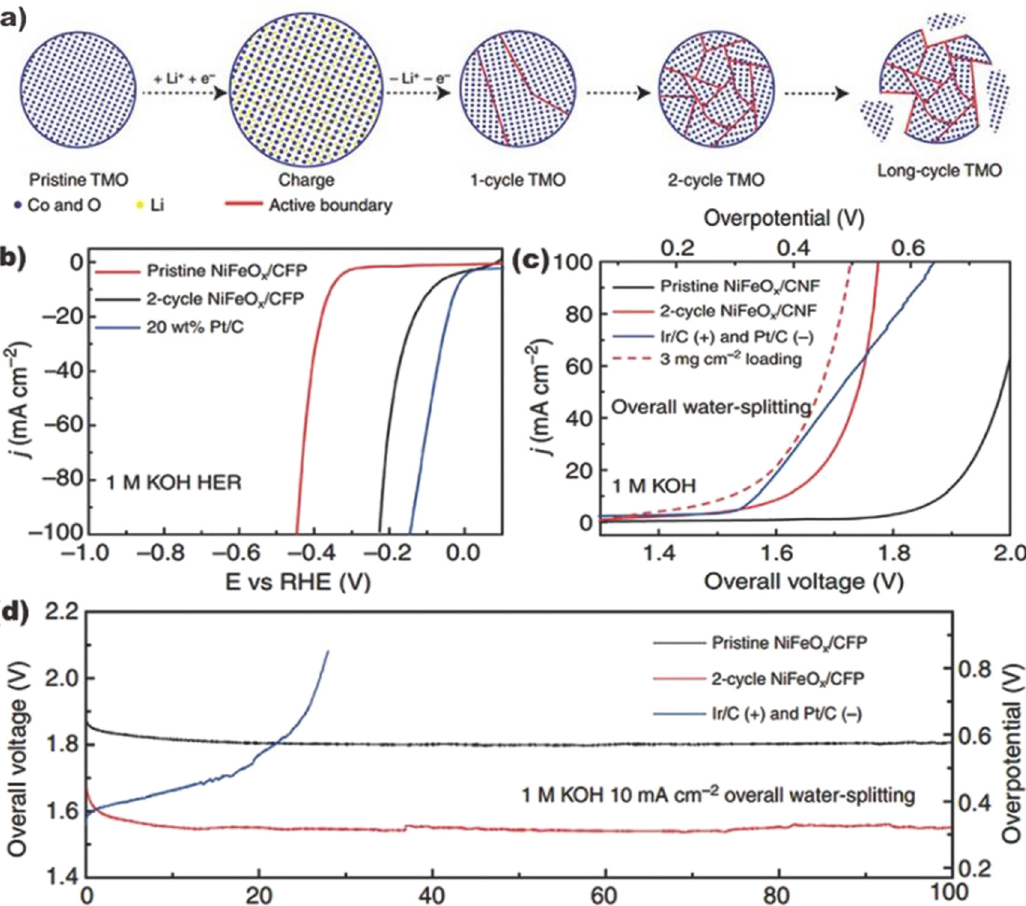
Figure 8: ( a ) Transition metal oxide ( TMO ) molecules continuously shift from single - crystalline to ultrathin correlated crystalline NPs. Stable cell loop may a ff ect particle dispersion. ( b ) The HER performance of 2 - loop NiFeO x /CFP remarkably increased from its pristine complement. ( c ) Two - loop NiFeO x /CFP as an HER as well as OER bifunctional electrocatalyst in basic solution ( 1 M KOH ) for complete water splitting. ( d ) Long - lasting constancy of 2 - loop NiFeO x /CFP for HER and OER catalysts compares to Ir and Pt combination. Redrawn from [ 130 ]